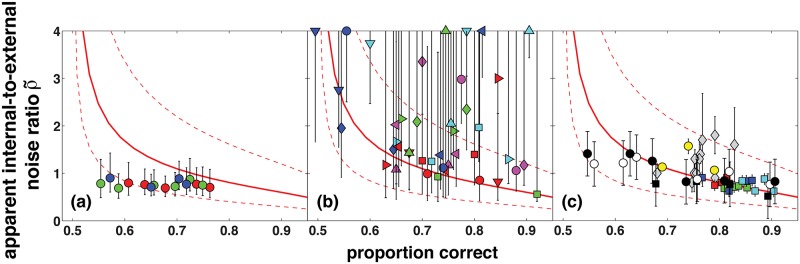
Results from two-pass experiments with human observers.In each panel the solid red line is a section of the lowest red line in Fig 1d, which represents the posterior probability matching model observer with no internal noise. The two dashed red lines have y-values twice as large and half as large as the solid red line. Error bars show 95% confidence intervals. (a) Experiment 1, practised observers. Each colour represents a different observer. (b) Experiment 2, unpractised observers. Each coloured symbol represents a different observer. (c) Data from Burgess and Colborne’s [12] Fig 2 (coloured squares) and Fig 4 (black squares, black circles, white circles), Neri’s [10] Table 1 (grey diamonds), and Murray et al.’s [17] Experiment 2 (yellow circles). For Burgess and Colborne, and for Murray et al., each data point represents a single observer. For Neri, each data point represents an average over several observers.